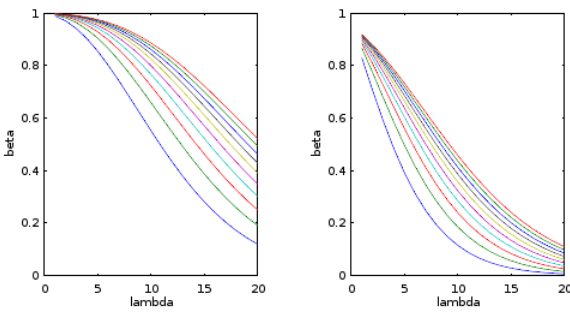
Figure 3: Probability of type 2 decision error β =F χ 2 (c | q, λ ) ver- sus λ for q = 1,...,10 (bottom // top) and α = 0.001 (left) as well as α = 0.05